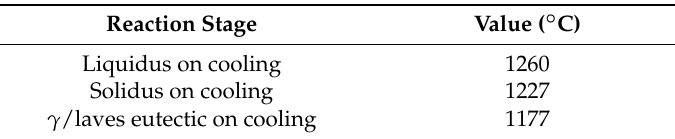
Table 2. Inconel 718 cooling